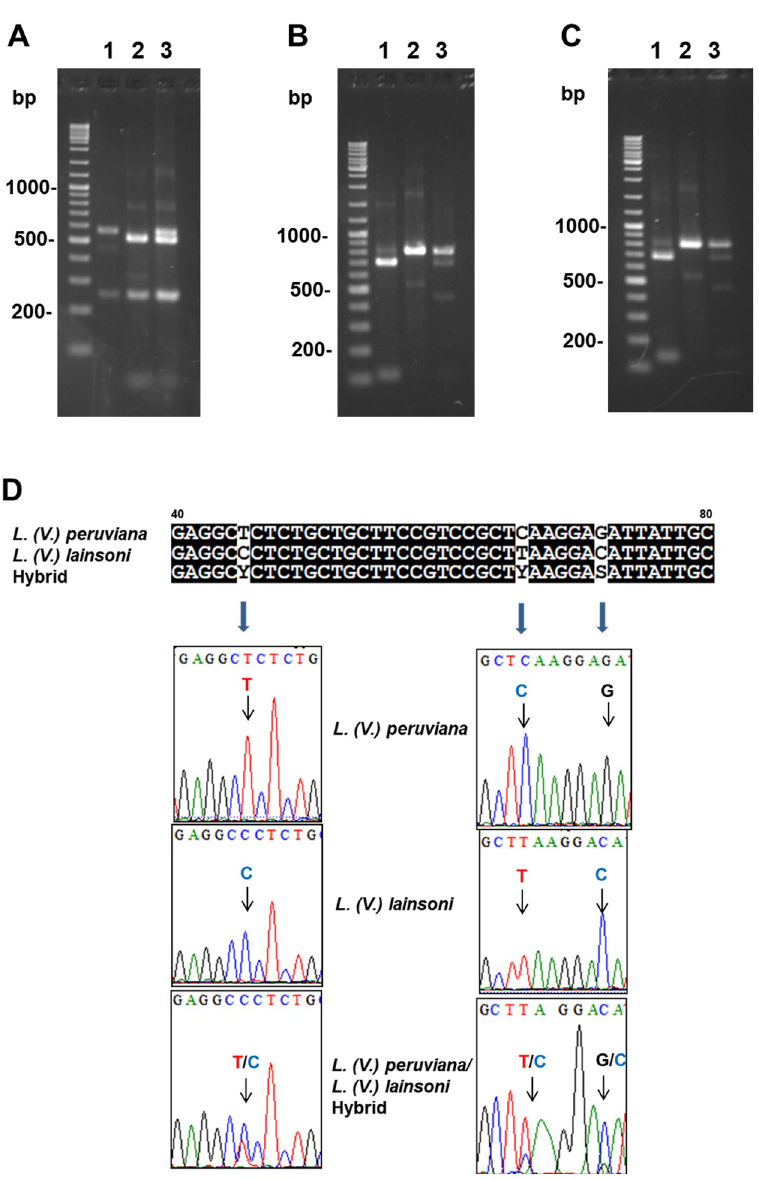
Fig 3. Differentiation between L . (V . ) peruviana and L . (V . ) lainsoni by PCR-RFLP and direct sequence analyses of mpi gene fragment. A, B, C. PCR amplification was performed with mpi gene-specific primers and the PCR products were digested with Hae III (A), Vpa k11BI (B), or Bst XI (C). 1. L . (V . ) peruviana , 2. L . (V . ) lainsoni , 3. a hybrid of L . (V . ) peruviana and L . (V . ) lainsoni . D. Direct sequence analysis showing three among several species-specific polymorphic sites of the Leishmania mpi gene